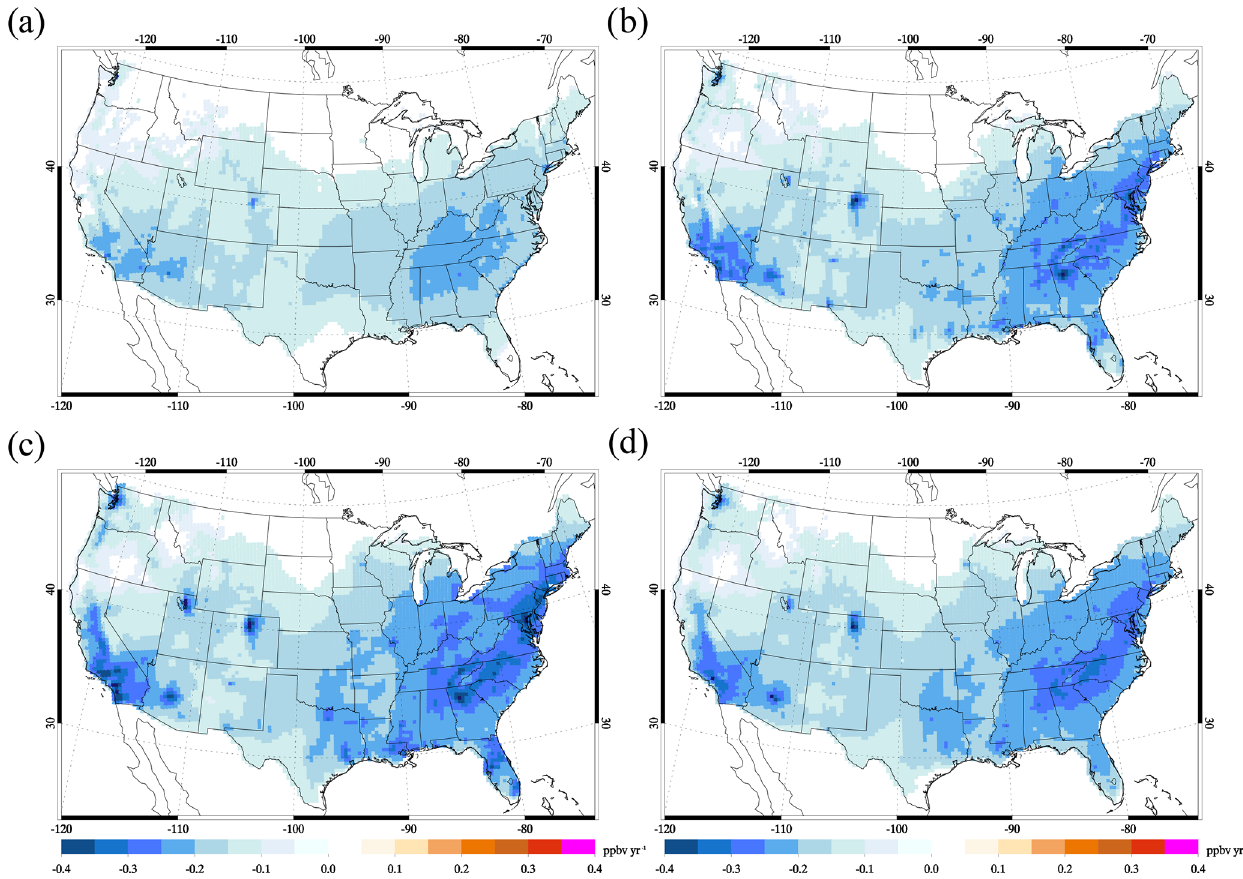
Figure 9. Trend in O x (O x =O 3 + NO 2 ) simulated by CMAQ during 1990–2015 at (a) 08:00LT, (b) 12:00LT, (c) 16:00LT and (d) at 20:00LT. We only show CMAQ grids with a statistically significant linear trend in the